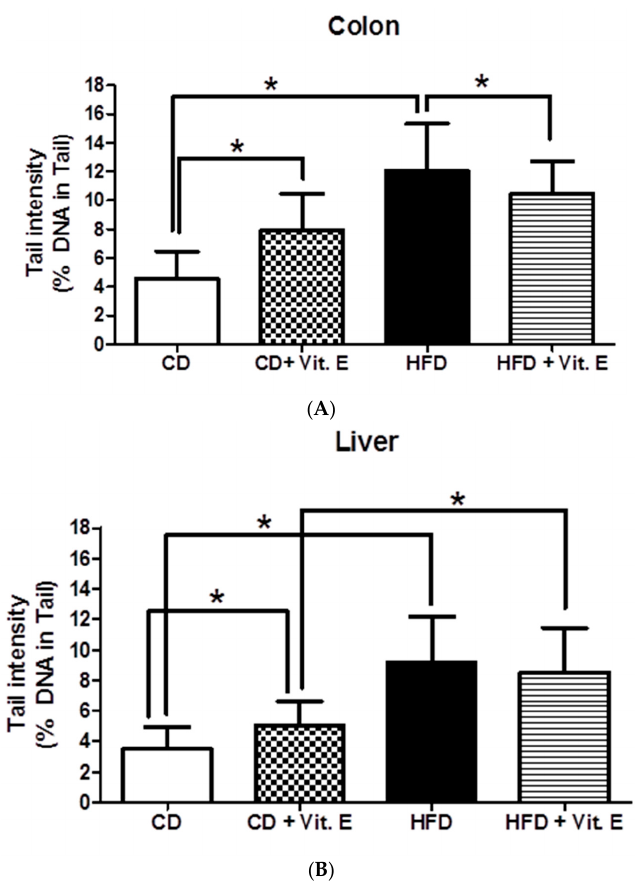
Figure 2. Impact of vitamin E supplementation on DNA damage in colon ( A ) and liver ( B ) of C57BL/6J male mice ( n = 15). Bars indicate means ± SD of results obtained with 15 animals per group. From